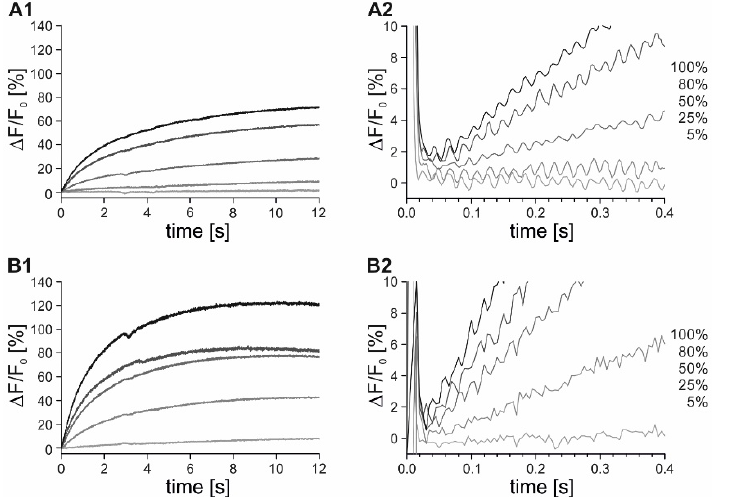
Figure 8. Photolysis of DEACM-cAMP for activating the CNG channel in flpTM-DmOct β 1 cells. FlpTM-DmOct β 1 cells were loaded with Fluo-4 and 10 µM ( A ) or 30 µM ( B ) DEACM-cAMP, respectively. Cells were mixed in a cuvette of a stopped-flow system with ES. After 2 s incubation a 10 ms UV-flash was triggered and the fluorescence intensity was recorded for 12 s ( A1 , B1 ). Measurements were repeated applying different light intensities (5–100%). The time point of triggering the light flash was defined as t = 0. To gain detailed temporal information on signal onset, the initial 0.4 s of the reactions was plotted ( A2 , B2 ).